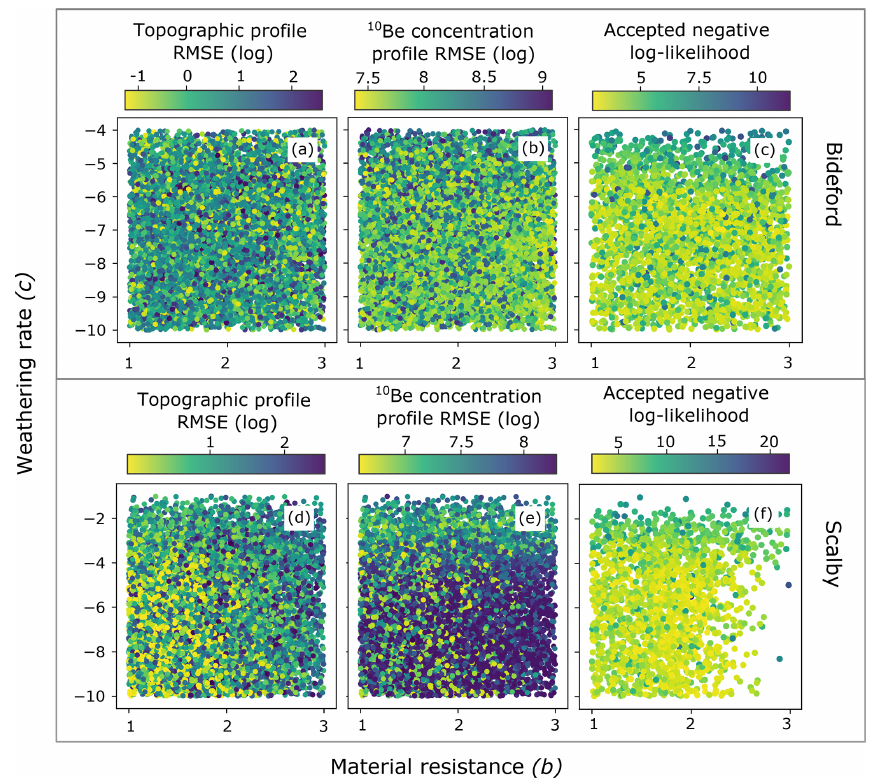
Figure 8. Objective function results for the material resistance ( b ) and weathering rate ( c ) parameters constructed from 50%–50% weighted MCMC analysis results for the Bideford site and Scalby site. The topographic profile RMSE (a, d) and 10 Be concentration profile RMSE (b, e) objective function spaces are constructed from all 10000 samples visited in the MCMC analysis. The combined likelihood objective function space (c, f) is constructed just using the accepted samples from the MCMC analysis. Dark blue corresponds to the worst samples that have the highest RMSE and negative log-likelihood scores, while bright yellow corresponds to the best samples that have the lowest RMSE and negative log-likelihood